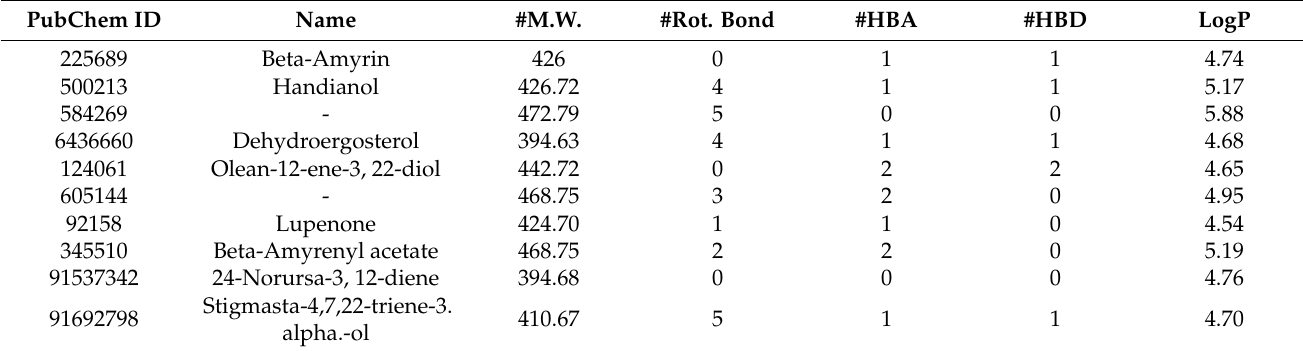
Table 5. The physicochemical properties of the selected top hit compounds.